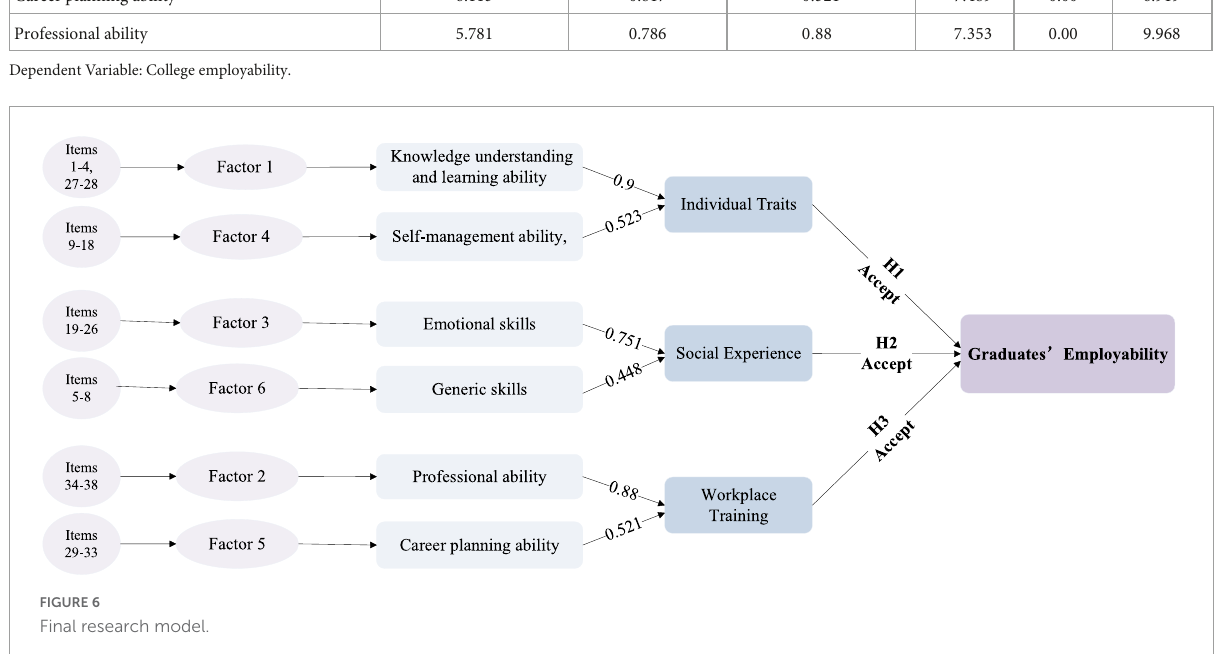
FIGURE6 Final research